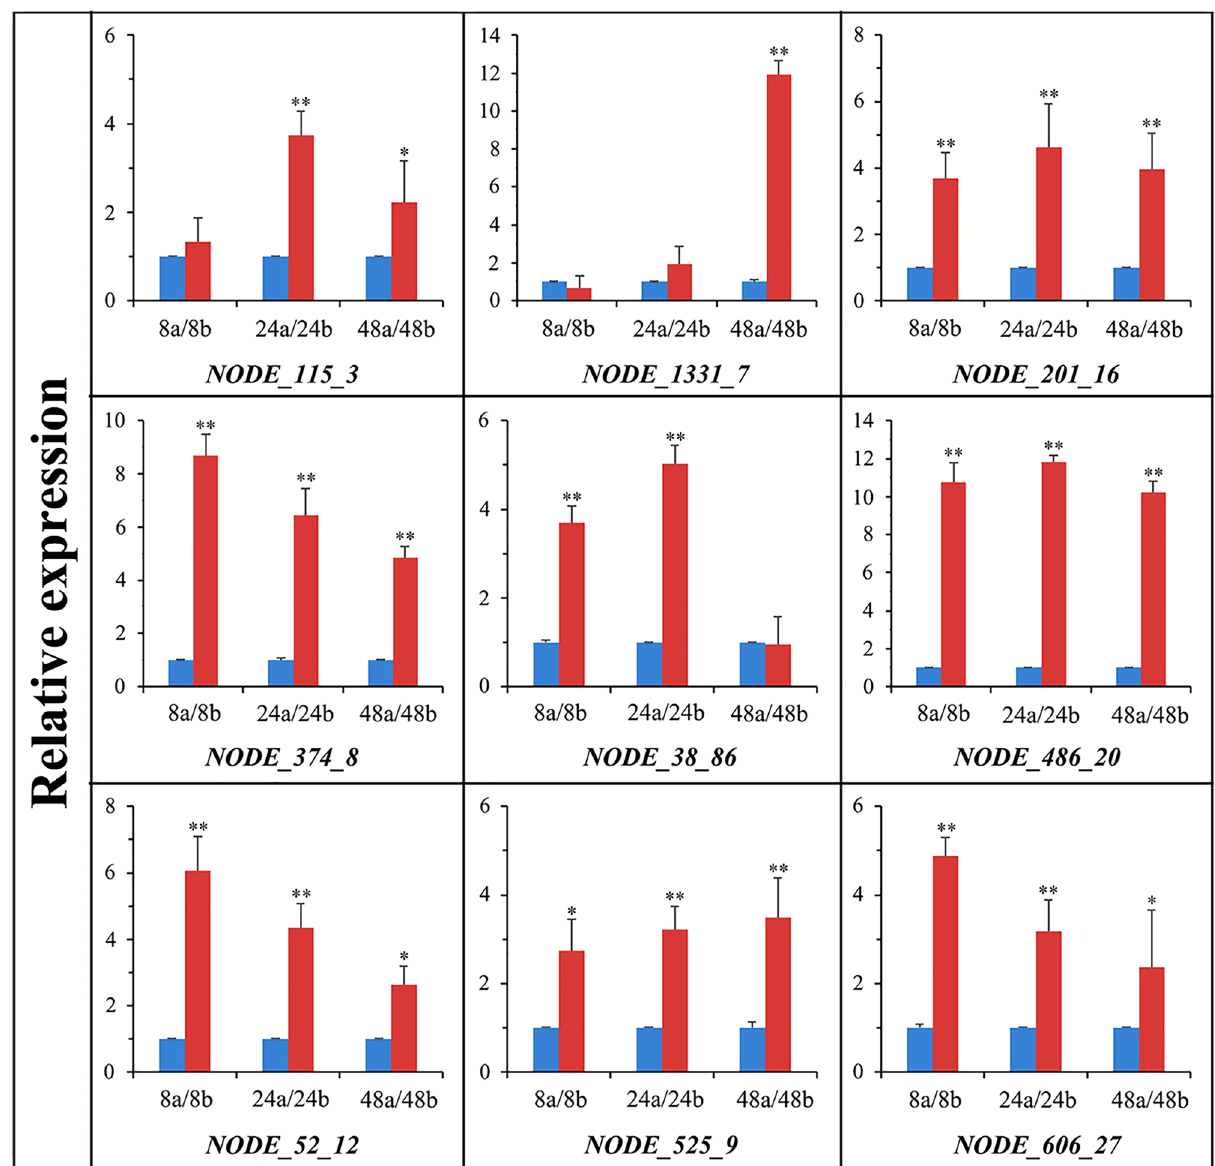
Figure 5. Expression levels of nine Crmapk -interacting genes in C. chloroleuca 67-1 under mycoparasitic conditions. The mycelia of 67-1 strain under the induction of sclerotia were collected at 8, 24 and 48 h. The letter “a” represents the controls (samples without sclerotia) and “b” represents the treatments induced by S. sclerotiorum sclerotia. Error bars indicate the standard deviation of three replicates. Statistical tests were carried out using Tukey’s test for multiple comparisons. Asterisks indicate statistically significant difference ( p <